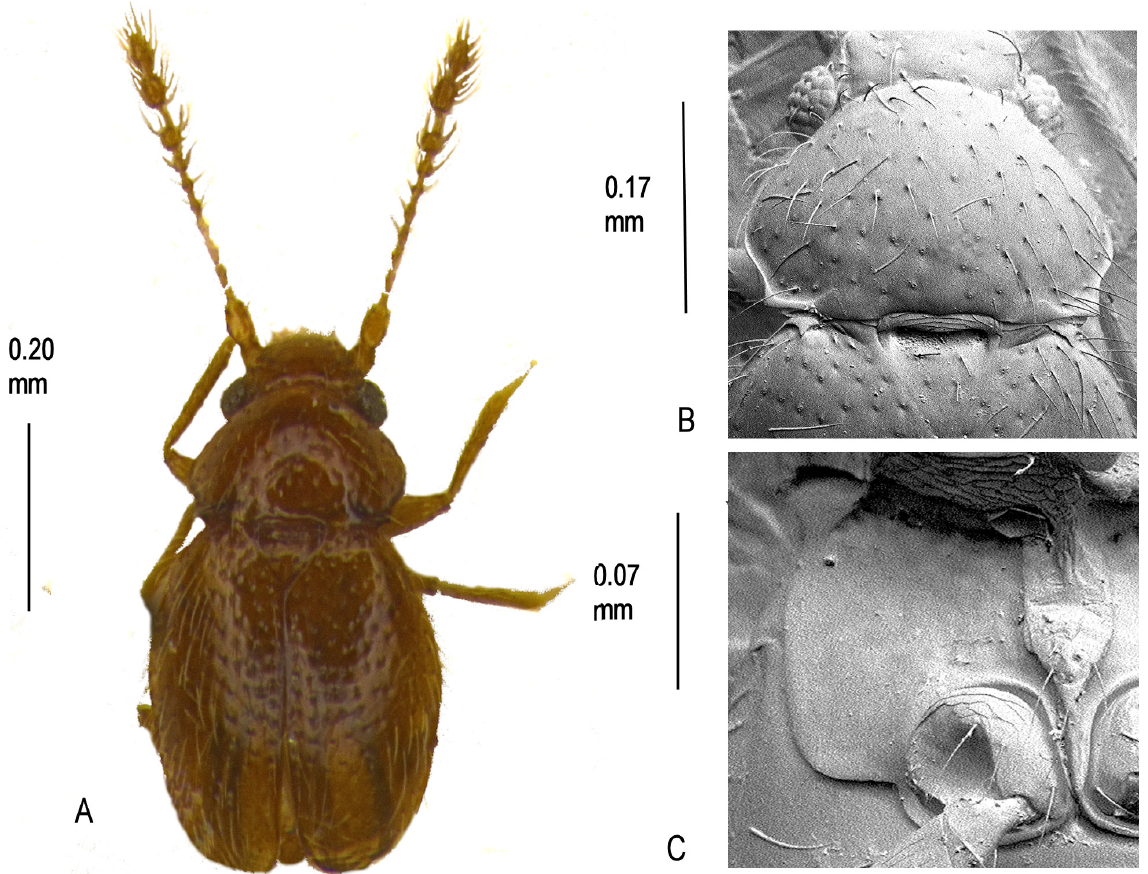
Fig. 79. Cissidium plaumanni sp. nov. A . Habitus. B . Pronotum, × 590. C . Mesoventrite showing median process of collar, lateral margin, mid-keel and keel,